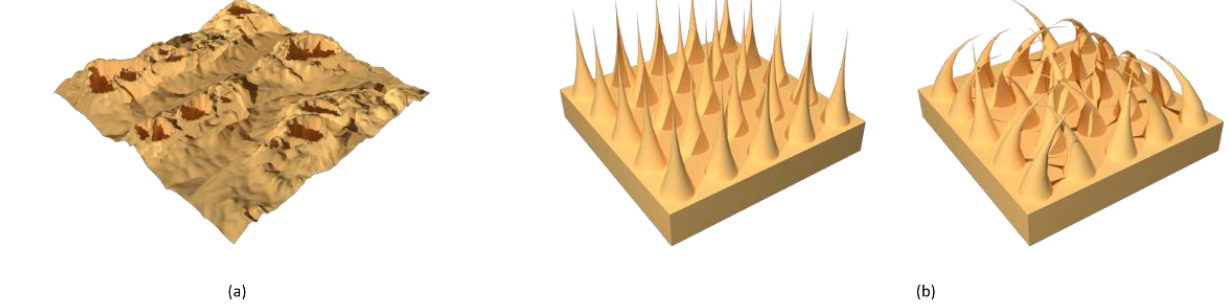
Figure 6. Effect of the concentration of hydrophobically modified silica nanoparticles on the water contact angle of sol–gel composite coatings prepared with sols of TEOS and MTES. Reproduced with permission from [41].